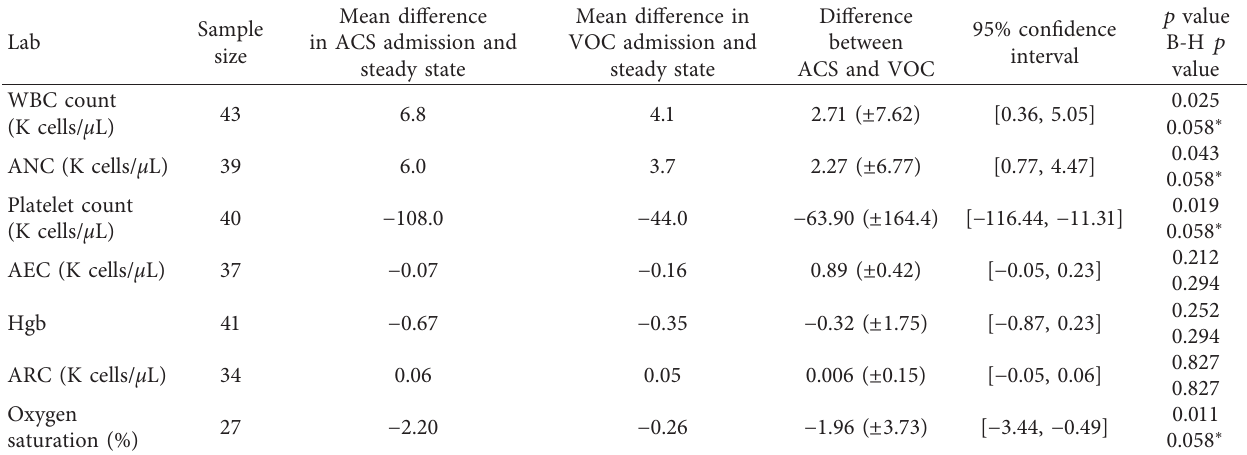
Table 1: Numerical change and analysis from steady state between VOC admission and VOC admission complicated by ACS. Lab